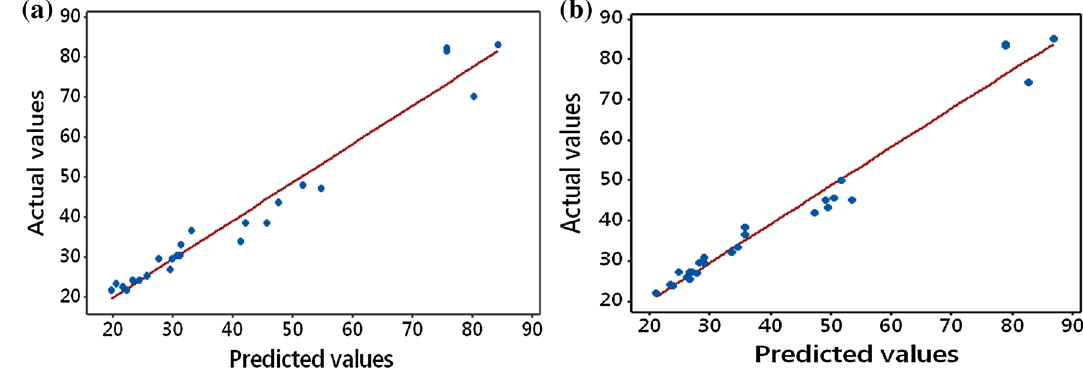
Fig. 5 Plot of predicted versus actual values for both responses a % COD removal efficiency, b % dicamba removal